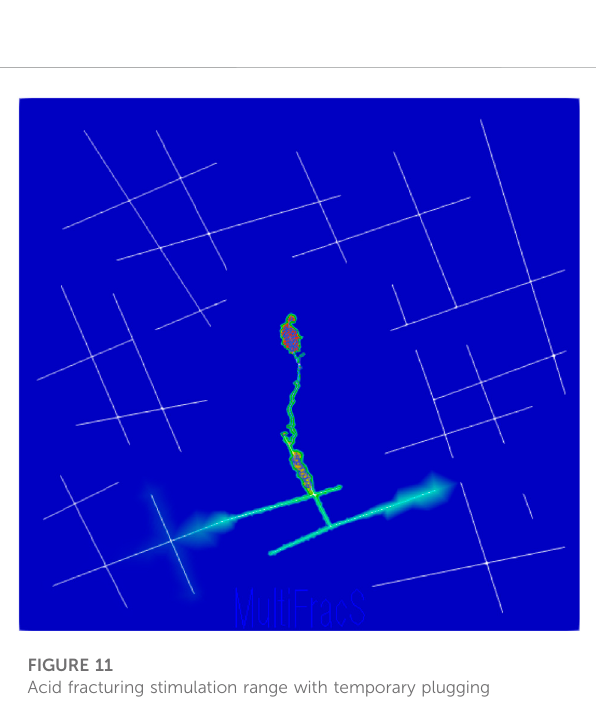
FIGURE 8 Acid fracturing stimulation range with injection displacement of 4 m 3 /min.